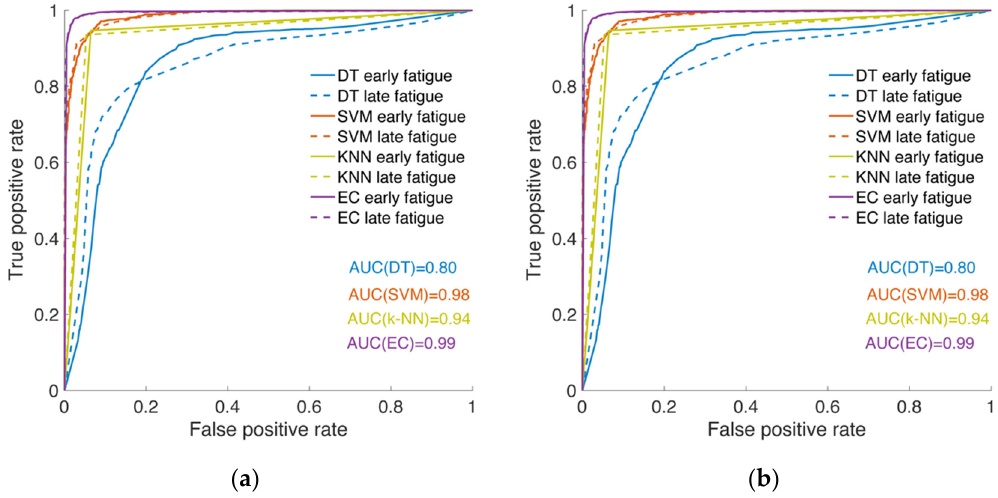
Figure 4. Receiver operating characteristic (ROC) curves of the trained models with ( a ) 45 and ( b ) 90 samples / window; early fatigue phase is plotted with straight line, late fatigue phase—with dashed